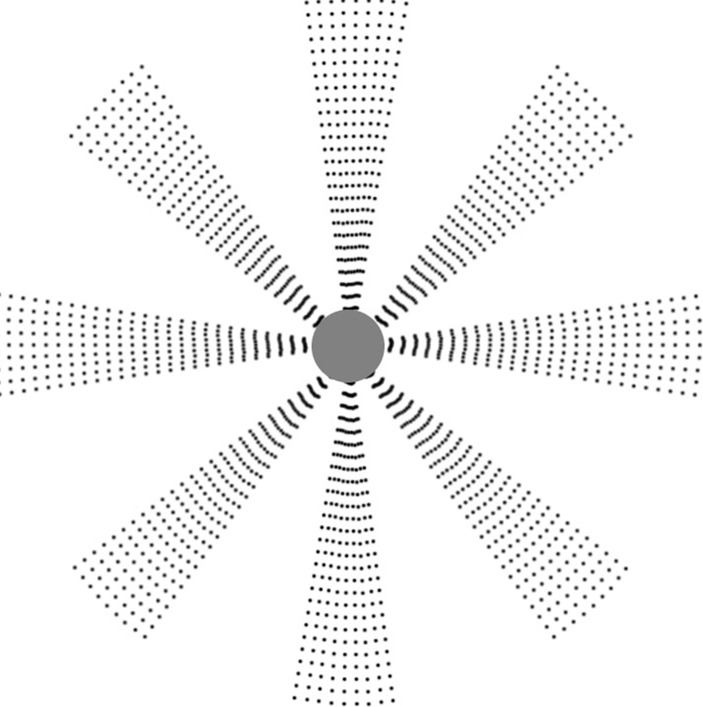
Diagrammatic presentation of the experimental design.The circular pollen donor N12-1 plot with radius 5m was planted at the center of experiment field. Pollen recipient dwarf male-sterile wheat (DMSW) was grown at eight compass directions. The radius of concentric circle of the recipient DMSW was 50 m.